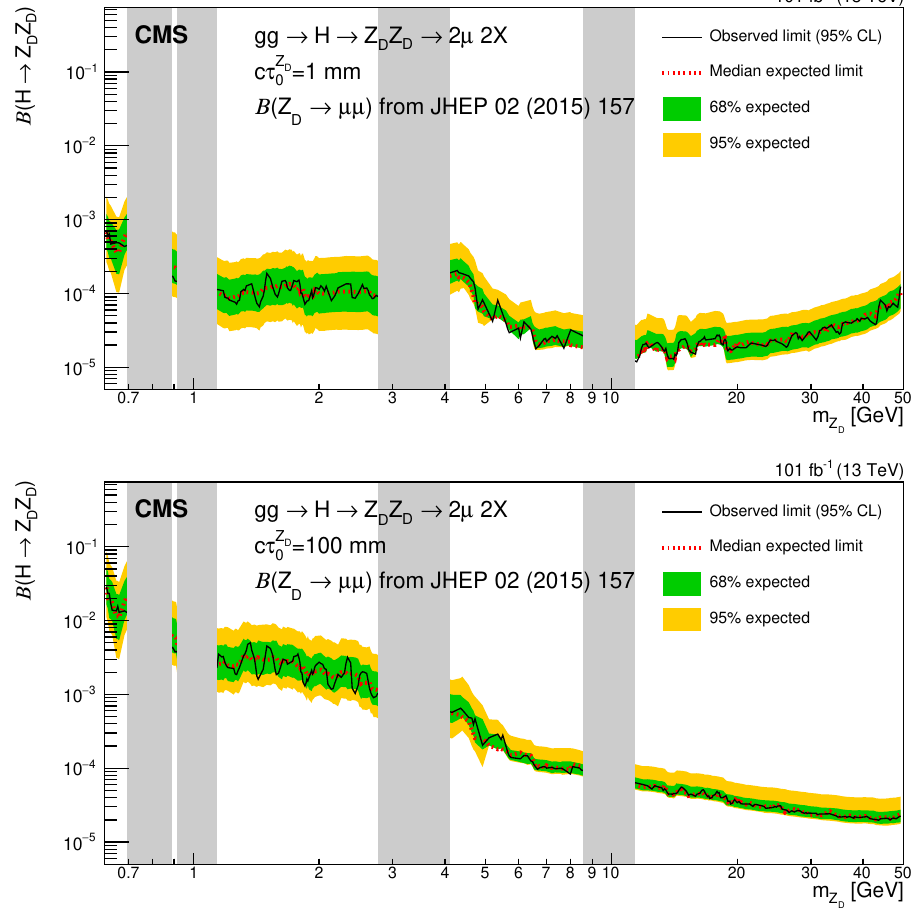
Z ) , as functions of Figure 8 . Exclusion limits at 95% CL on the branching fraction B (H → Z D D the signal mass ( m ) for cτ Z D = 1 mm (upper) and 100 mm (lower), for the H → Z Z signal Z D D D 0 model, assuming values of B (Z → mm ) from the model of ref. [6]. The solid black (dashed red) line D represents the observed (median expected) exclusion. The inner green (outer yellow) band indicates the region containing 68 (95)% of the distribution of limits expected under the background-only hypothesis. At m & 5 GeV the bands are asymmetrical, due to the small number of events observed Z D in the corresponding search bins, especially those with l > 0 . 2 cm. The vertical gray bands indicate xy mass ranges containing known SM resonances, which are masked for the purpose of this search. The limits are obtained using the combination of all dimuon and four-muon event